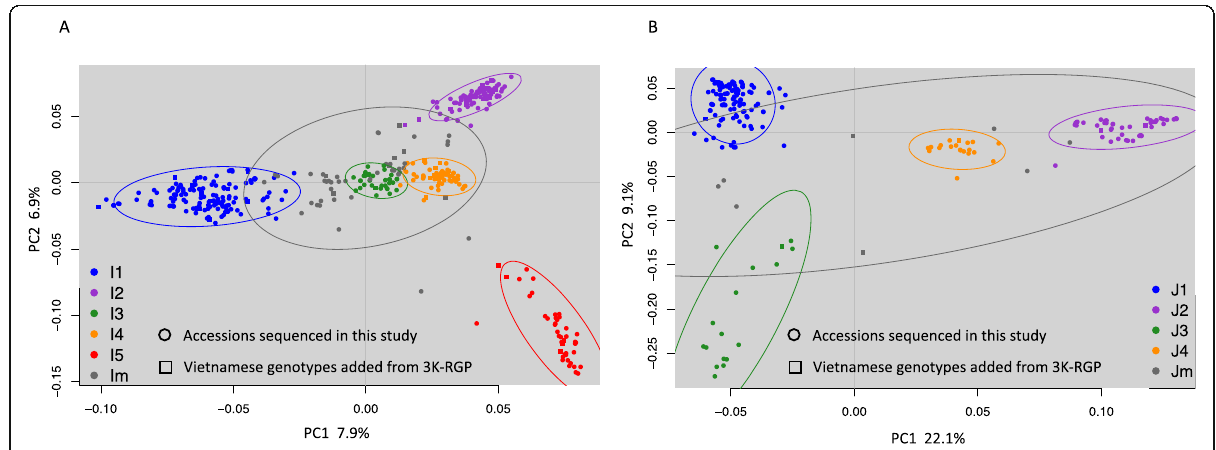
Fig. 2 PCA analysis of Indica and Japonica Vietnamese subpopulations. a PCA analysis of 426 accessions from Vietnam using the top two components to separate the five Indica subpopulations. The ellipses show the 95% confidence interval. b PCA analysis of 211 accessions from Vietnam using the top two components to separate the four Japonica subpopulations. The ellipses show the 95% confidence